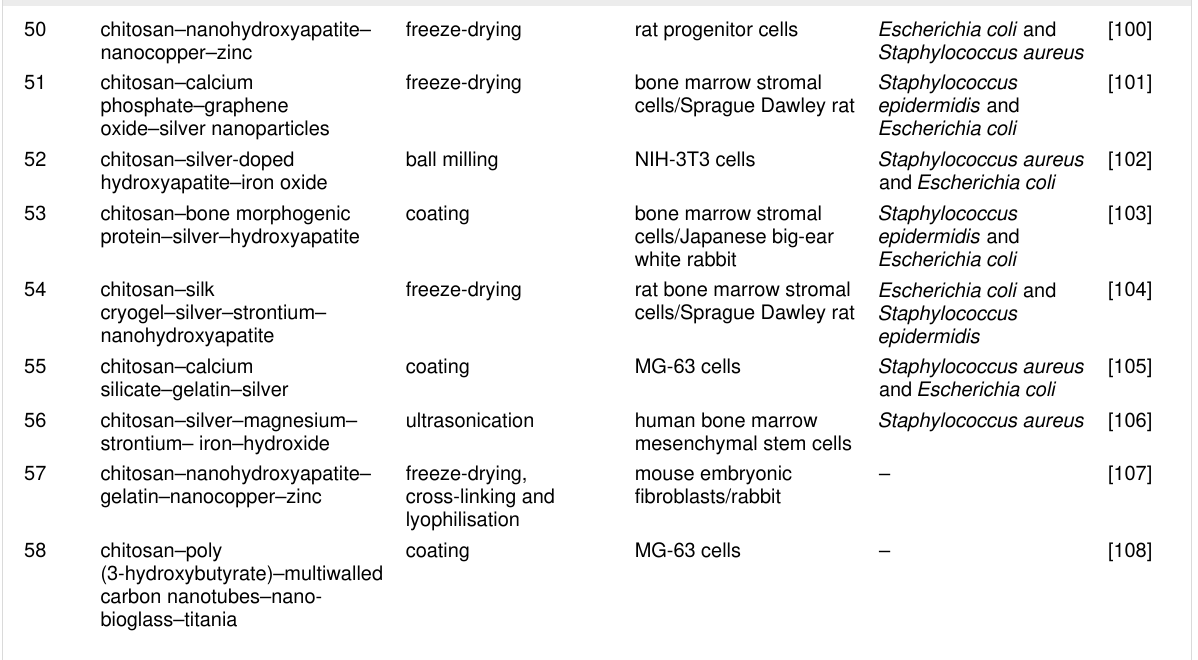
Table 1: Combinations of chitosan with several polymeric materials and nanoparticles to mimic the natural bone function. (continued)